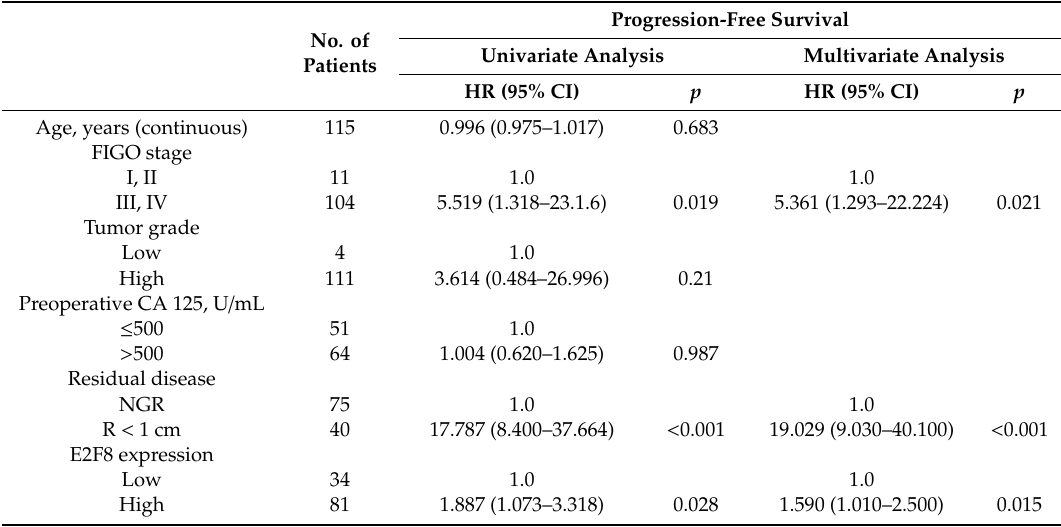
Table 1. Univariate and multivariate analyses of various factors correlated with progression-free